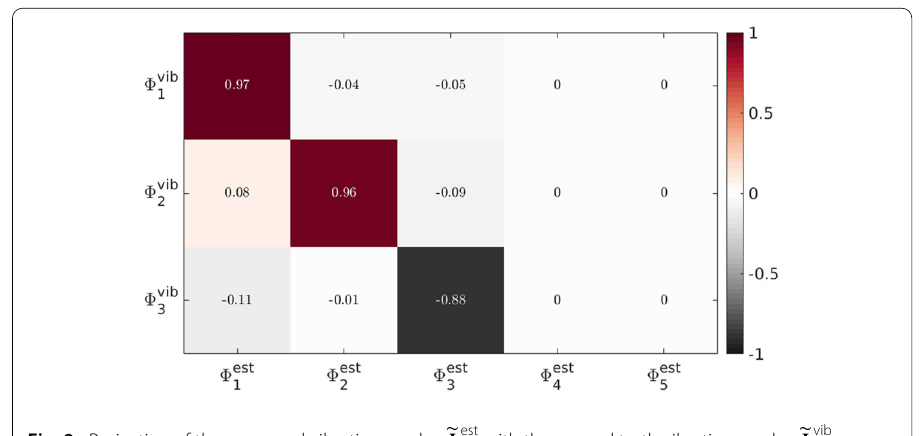
Fig. 9 Projection of the measured vibration modes (cid:20) (cid:2) est i with the ground truth vibration modes (cid:20) (cid:2) vib i